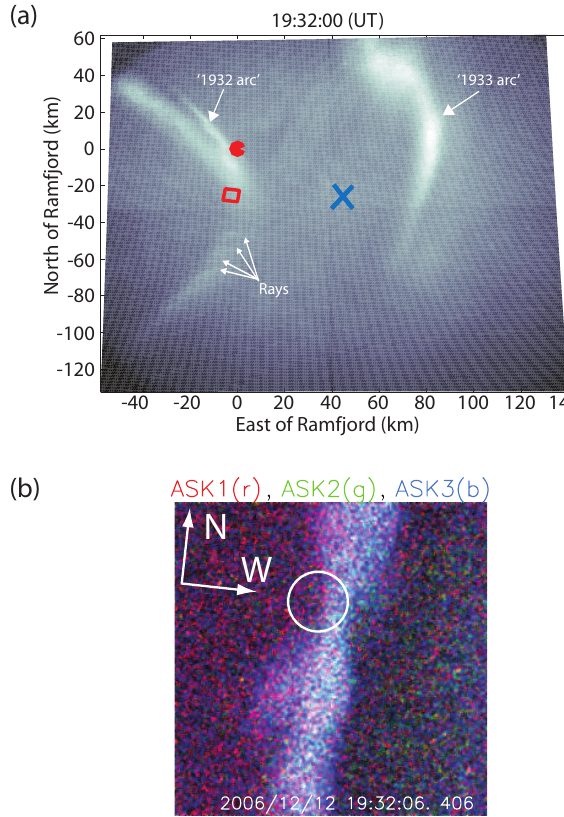
Fig. 4. (a) ALIS image taken from Skibotn at 19:32:00UT. The Fig. 4. a) ALIS image taken from Skibotn at 19:32:00 UT. The FOV FOV of ASK at 110km altitude is marked with a red box. The of ASK at 110 km altitude is marked with a red box. The location location of Ramfjordmoen and Skibotn are marked as a red dot and Fig. 4. a) ALIS image taken from Skibotn at 19:32:00 UT. The FOV of Ramfjordmoen and Skibotn are marked as a red dot and a blue a blue cross, respectively. The 1932 and 1933 arcs discussed in this of ASK at 110 km altitude is marked with a red box. The location cross, respectively. The 1932 and 1933 arcs discussed in this paper paper can both be seen at this time. (b) False colour overlay of I of Ramfjordmoen and Skibotn are marked as a red dot and a blue can both be seen at this time. b) False colour overlay of I cross, respectively. The 1932 and 1933 arcs discussed in this paper (red), I O + (green) and I O (blue) from ASK, for the 1932 arc. The I (green) and I O (blue) from ASK, for the 1932 arc. The location can both be seen at this time. b) False colour overlay of I O + location of the radar beam is marked with a circle. of the radar beam is marked with a circle. I (green) and I O (blue) from ASK, for the 1932 arc. The location O + of the radar beam is marked with a circle.